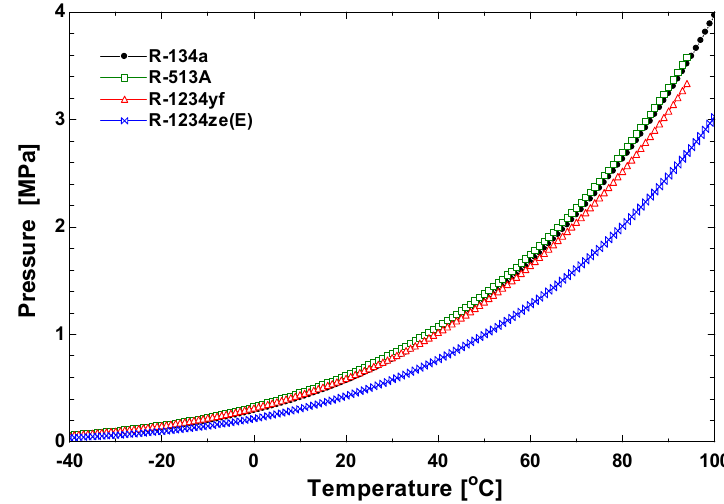
Figure 1. Saturation vapor pressures of R-134a alternative refrigerants [11] .